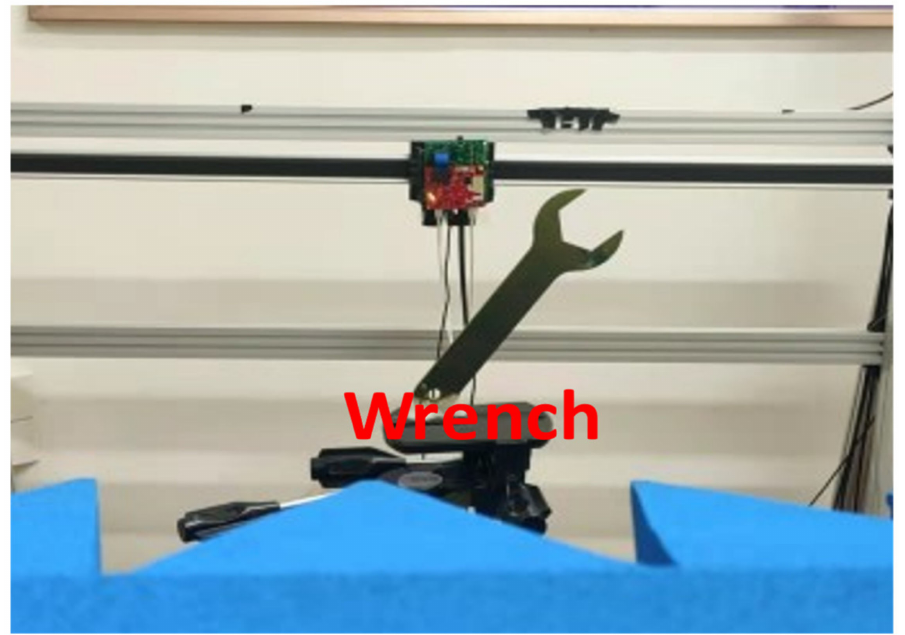
Figure 6. The wrench optical